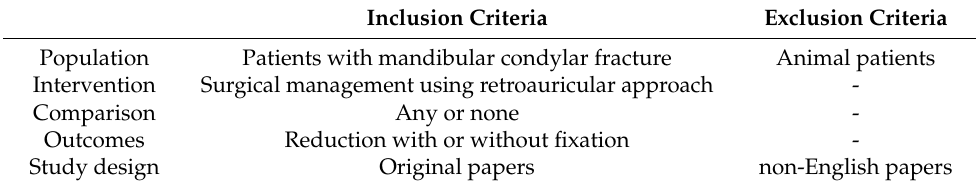
Table 1. Inclusion and exclusion criteria. Description in the